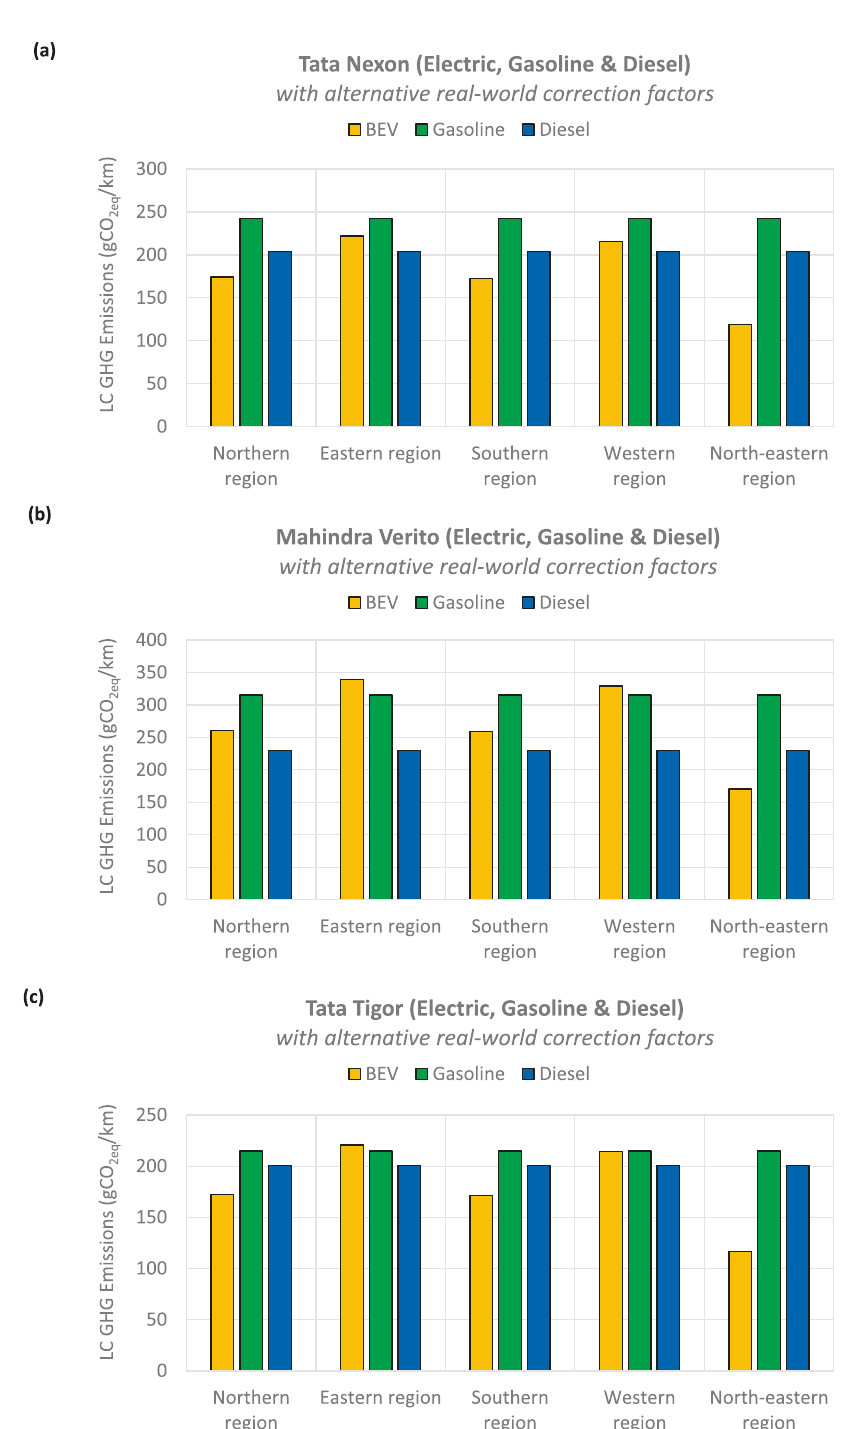
emissions for the two fuels were based on the ef fi ciency and vehicle tailpipe emissions given below.